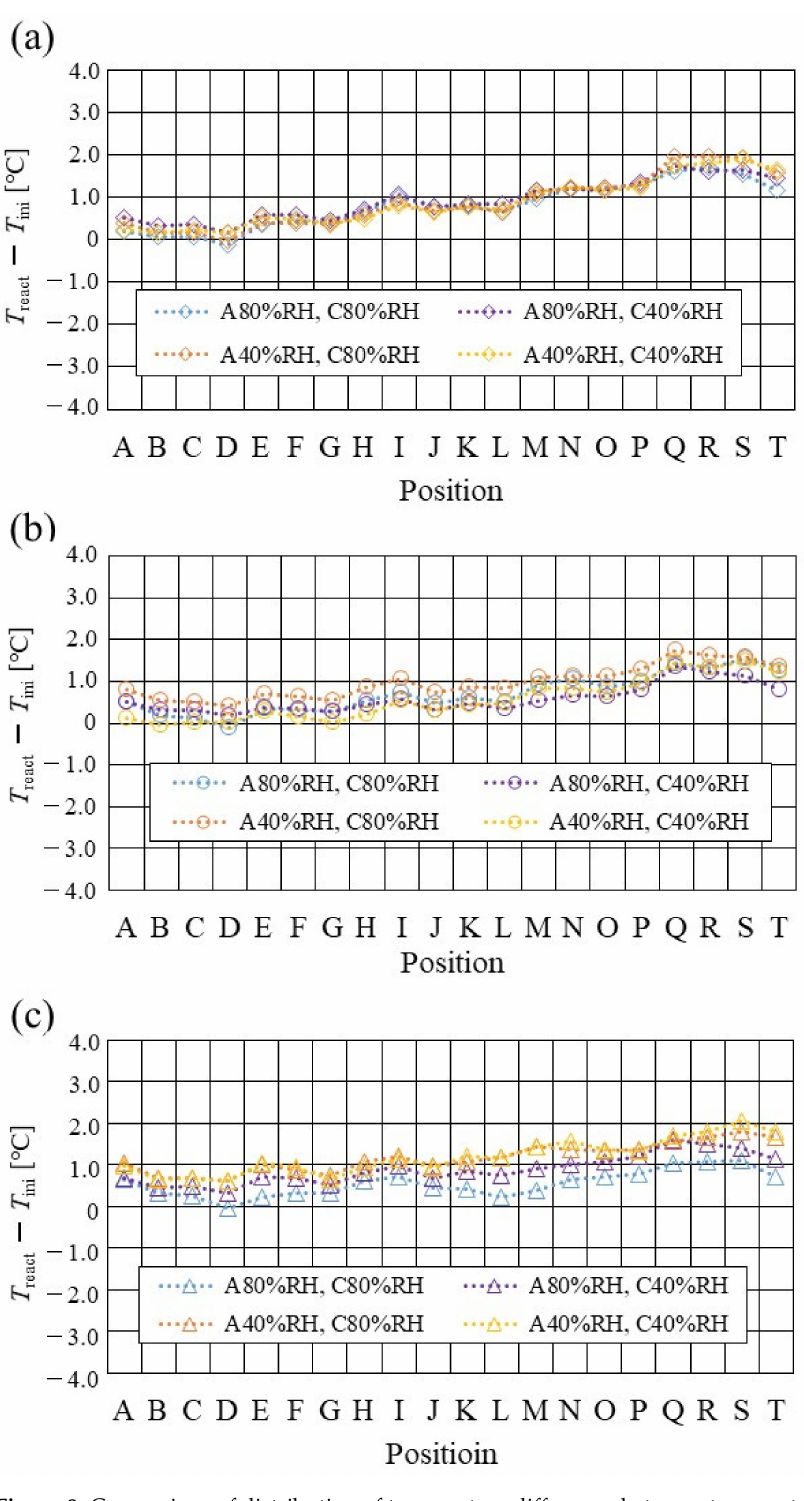
Figure 8. Comparison of distribution of temperature difference, between temperature at reaction sur- face and initial operation temperature, among different relative humidity conditions and initial oper- ation temperature for the separator thickness of 1.5 mm: ( a ) the initial operation temperature = 80 ◦ C, ( b ) the initial operation temperature = 90 ◦ C, ( c ) the initial operation temperature = 100 ◦